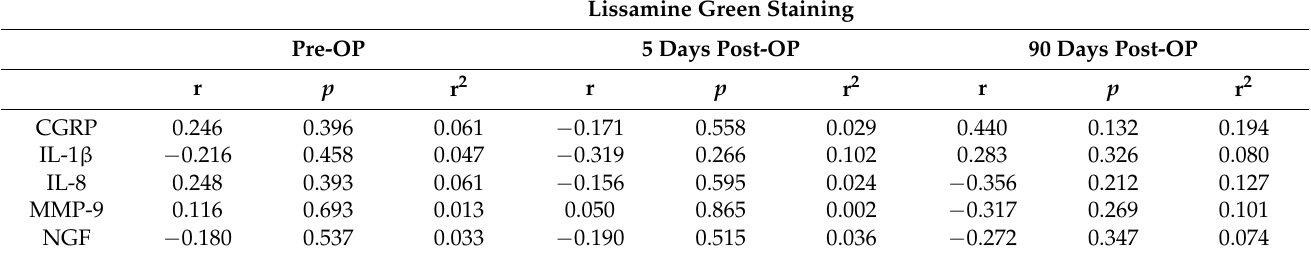
Table 6. Correlation between protein concentration and lissamine green staining score. Abbreviations: CGRP = calcitonin gene-related peptide; IL = interleukin; MMP-9 = matrix metalloproteinase-9; NGF = nerve growth